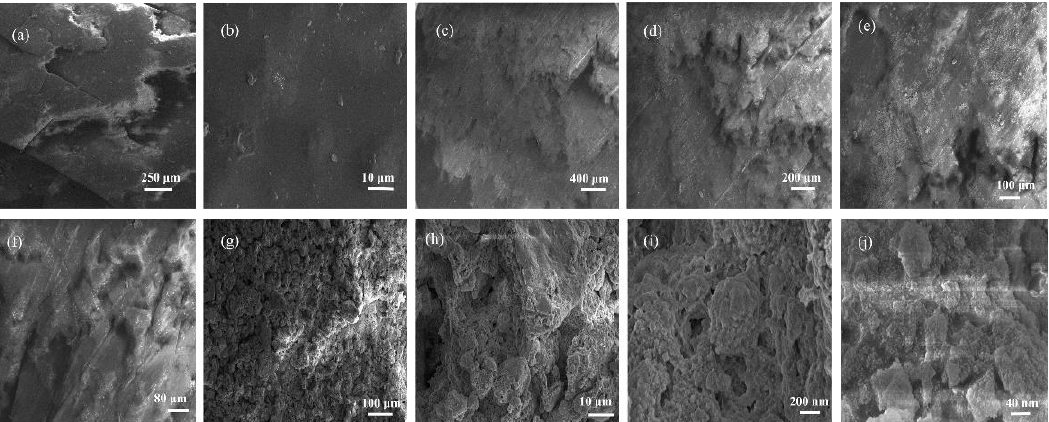
Figure 3. ( a ) SEM images of the surface of composite insulator. ( b ) Magnified SEM images of the surface of composite insulator. ( c ) SEM images of PDMS surface. ( d – f ) Magnified SEM images of PDMS surface. ( g ) SEM images of FAS-17-modified nano-SiO 2 /PDMS surface. ( h – j ) Magnified SEM images of FAS-17-modified nano-SiO 2 /PDMS surface.